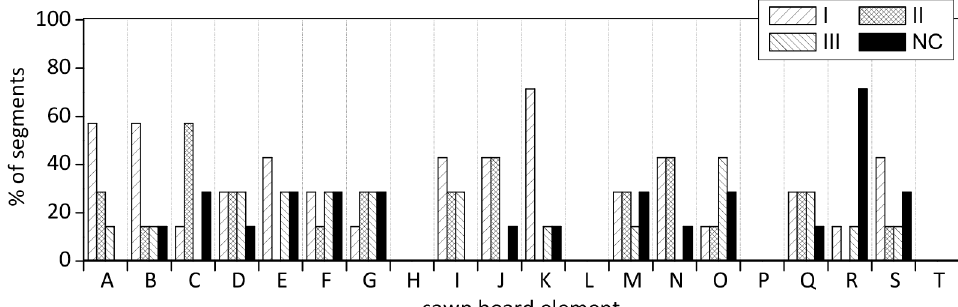
Fig. 7. Percentage distribution of segments included in each visual grading class according to UNI 11119:2004 for sawn boards (beams H, L, P and T were tested until failure in Phase 2)